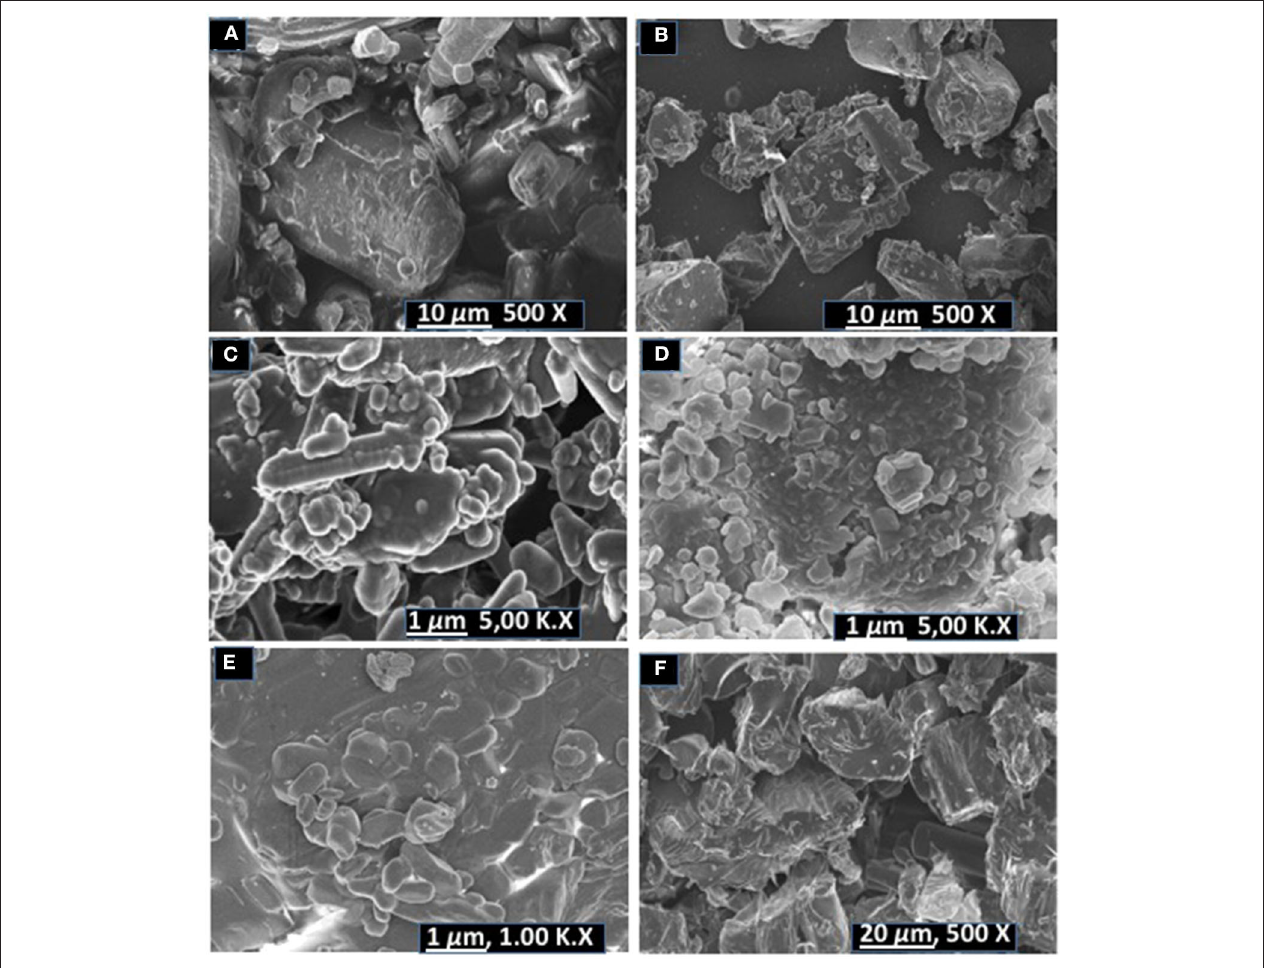
FIGURE 6 | SEM micrographs of (A) pyrazinamide, (B) isoniazid, (C) PGA (2:1) co-crystal, (D) INHGA (2:1) co-crystal (E) pentanedioic acid, and (F) isoniazid-pentanedioic acid physical mixture.